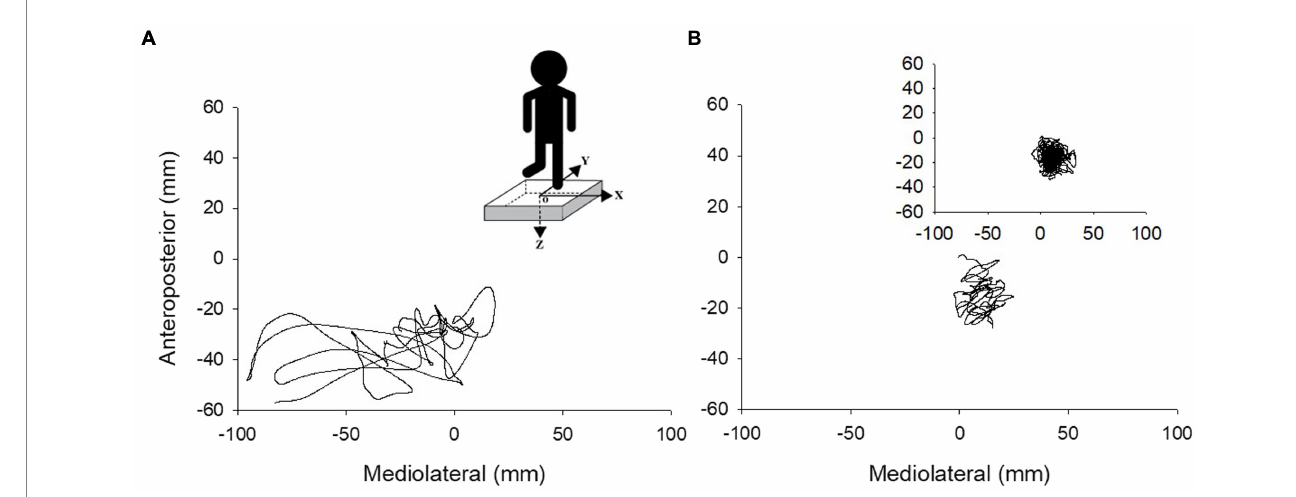
FIGURE 1 Center of pressure traces during 10 s of unipedal stance for an older adult with PD (A) and older adult without PD (B) . Insert in A shows the force plate with the x , y , and z axes of force and the center of the force plate (o), and the insert in B depicts a complete 60 s trial for one older adult without PD.